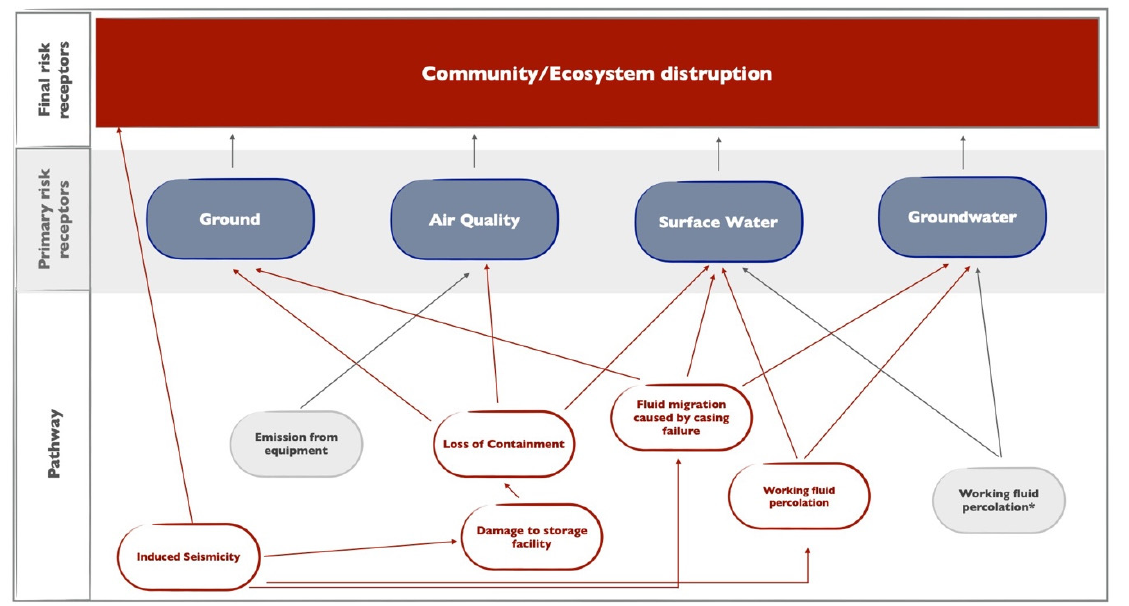
Figure 9. Risk pathways in Phase 2: Operation and maintenance. Grey circles identify events related to ordinary routine operations, i.e., mostly of LCA analysis. Red circles identify events related to incidents and/or extreme events, i.e., those more closely related to MRA.